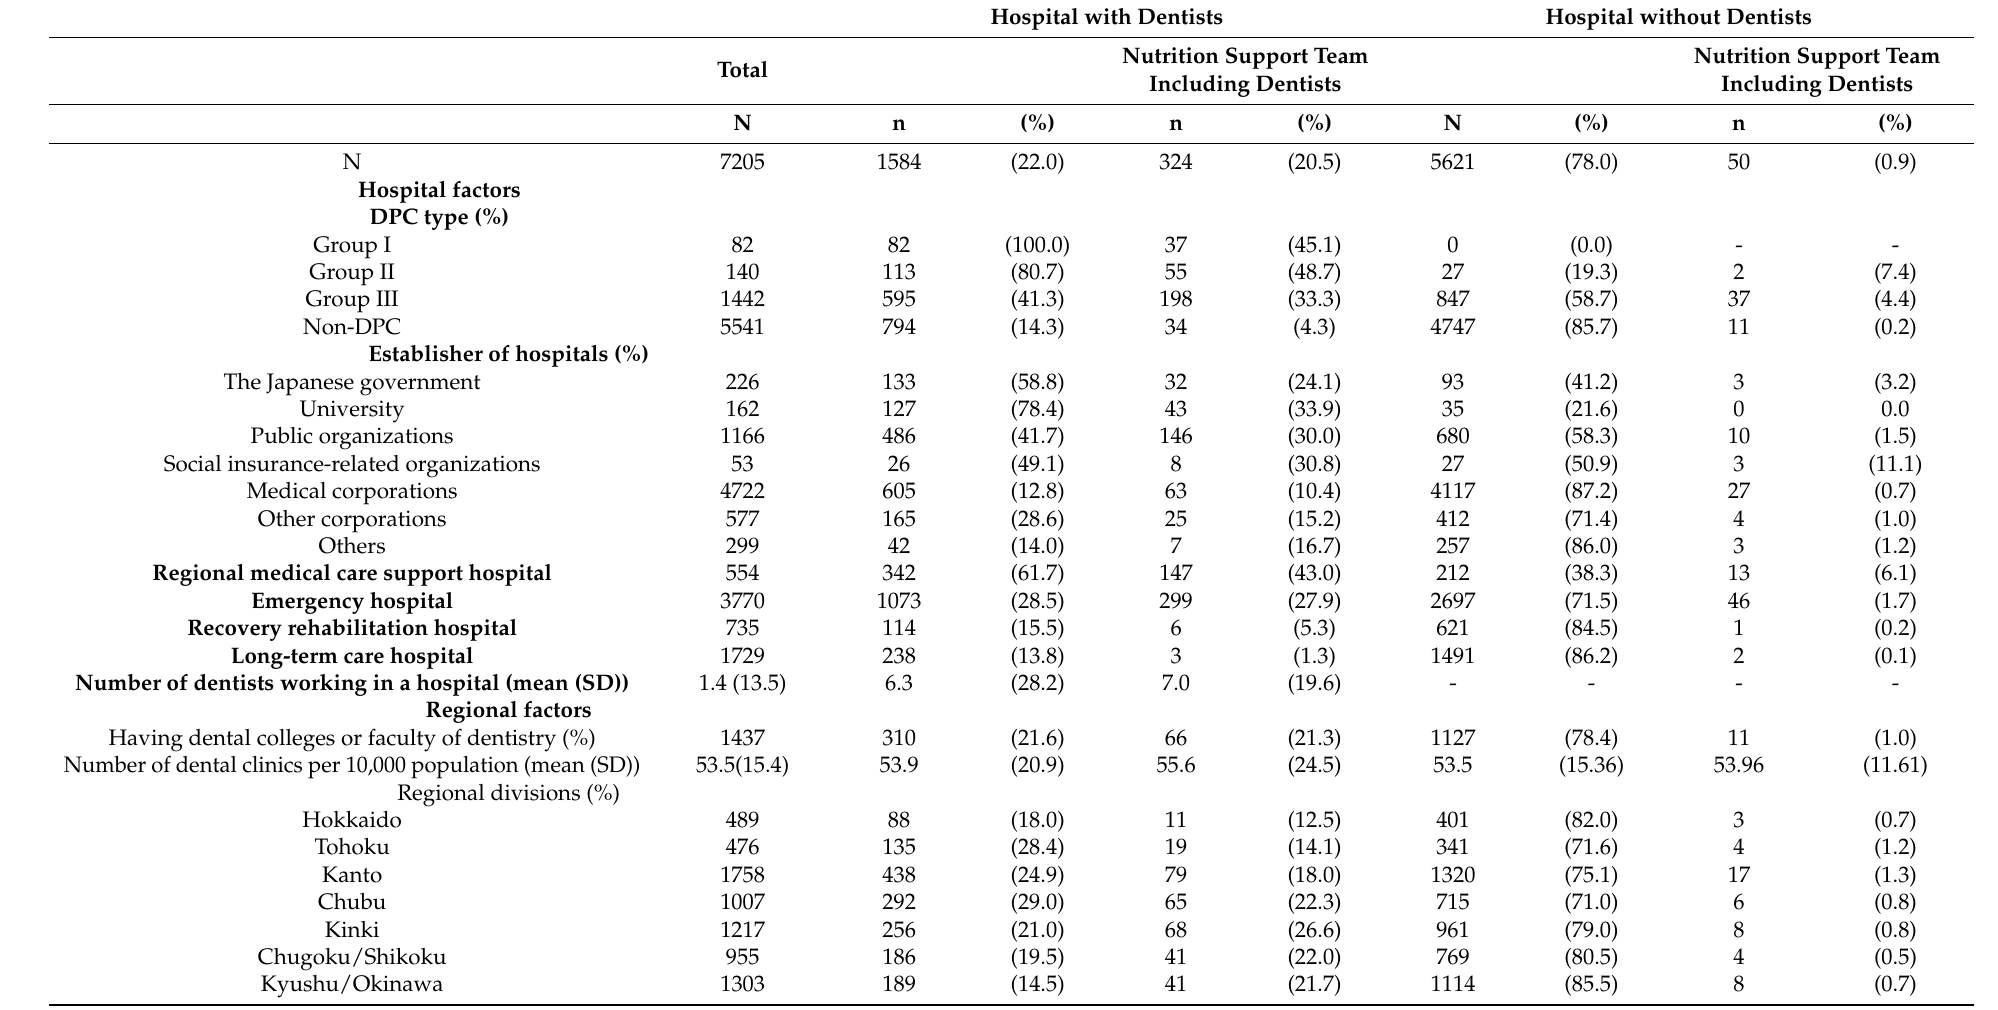
Table 1. Characteristics of hospitals with/without dentists and having a nutrition support team including